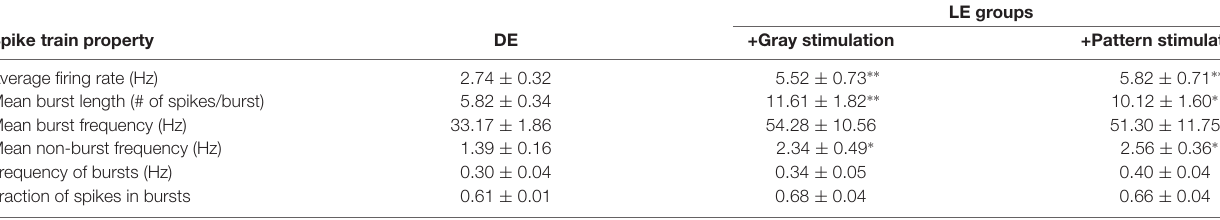
TABLE 1 | Spike train properties analyzed from in vivo primary visual cortex (V1) layer 4 (L4) cells.